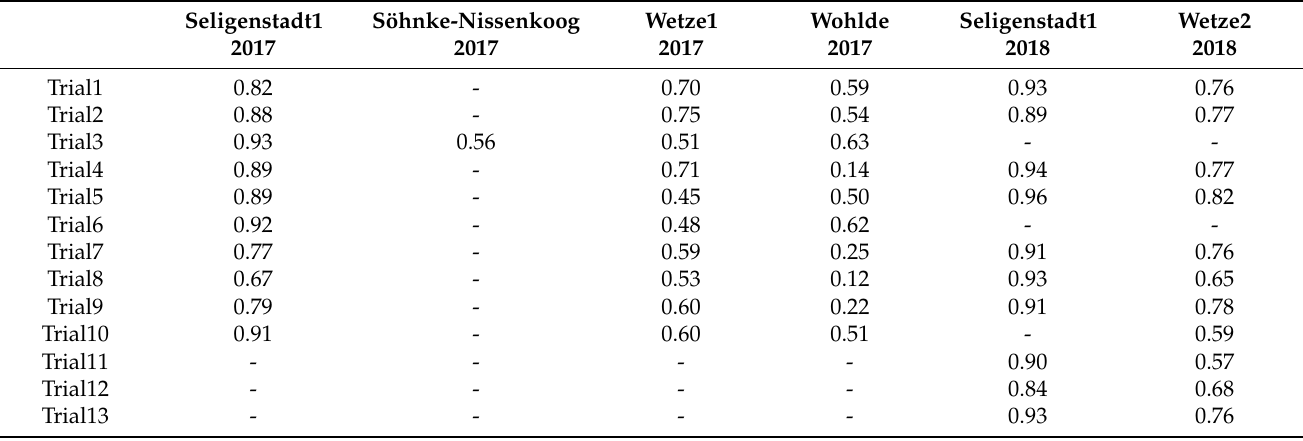
Table 2. Repeatability of replicated field trials. Trials with a repeatability below 0.4 were excluded before performing further